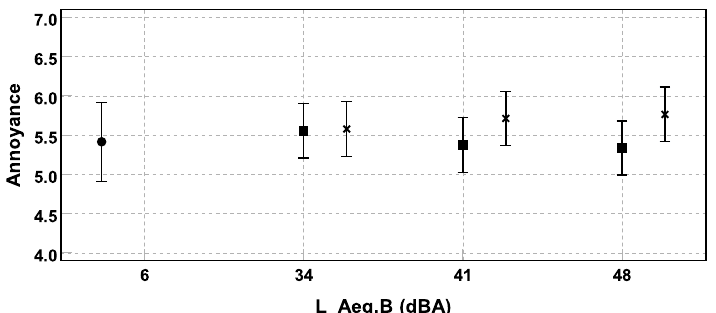
Figure 5. Interaction (experiment 1) background type and L Aeq,B : Mean acoustic comfort ratings across subjects and their 95% confidence intervals are depicted. Circle ( for no, less eventful, and eventful background, respectively. Note that only the annoyance range from 4–7 is shown here, although the scale ranged between 0 to